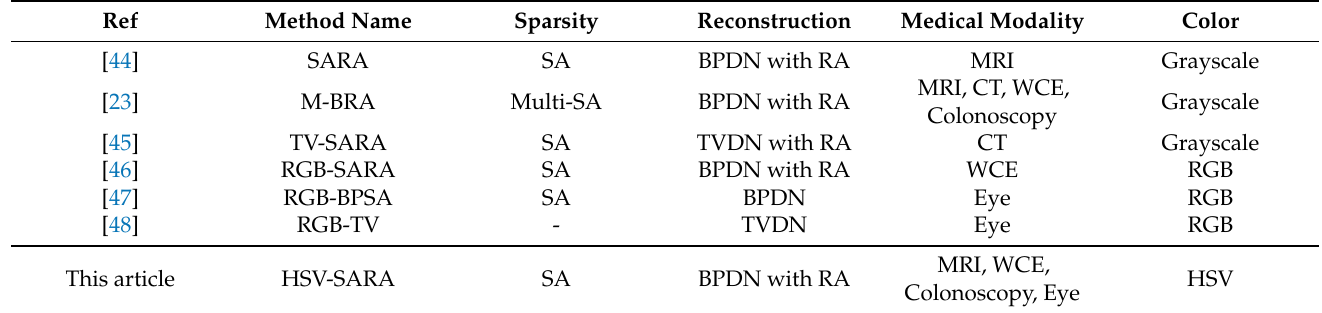
Table 1. Related